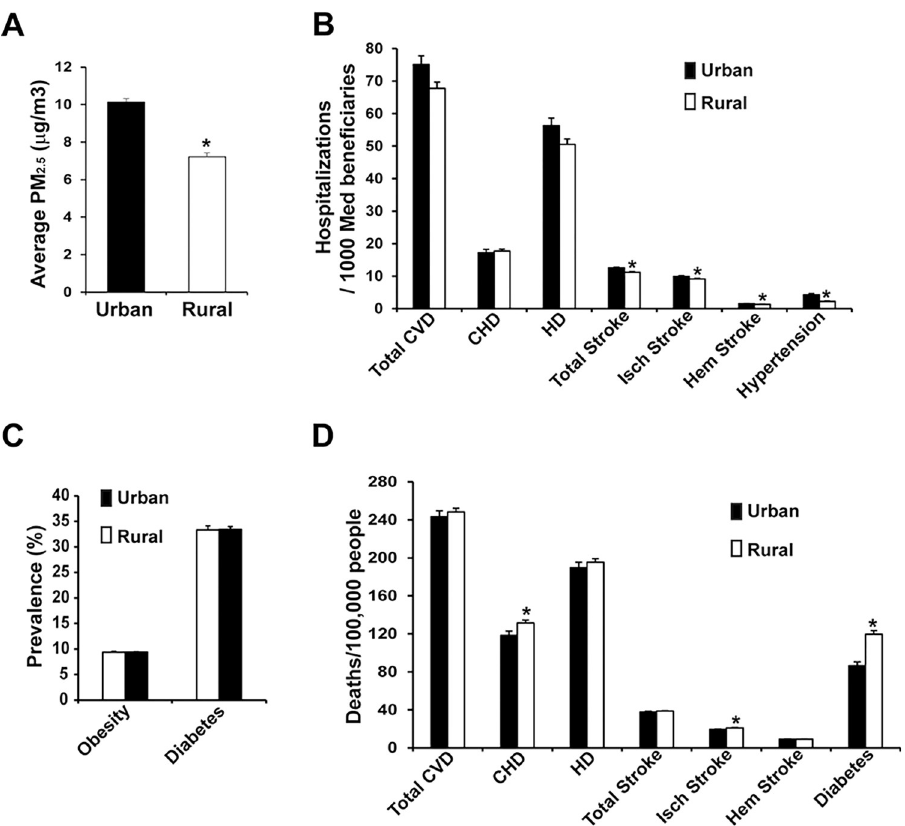
Fig 4. Bar graphs comparing average urban vs. rural county values for A. PM 2.5 concentration, B. Disease Hospitalization Rate, C. Prevalence rate for obesity and diabetes, and D. Disease Death Rate. � represents a statistically significant (p-value < 0.05) difference between urban and rural values. Error bars depict standard